Question: Generate an informative caption for the figure above.
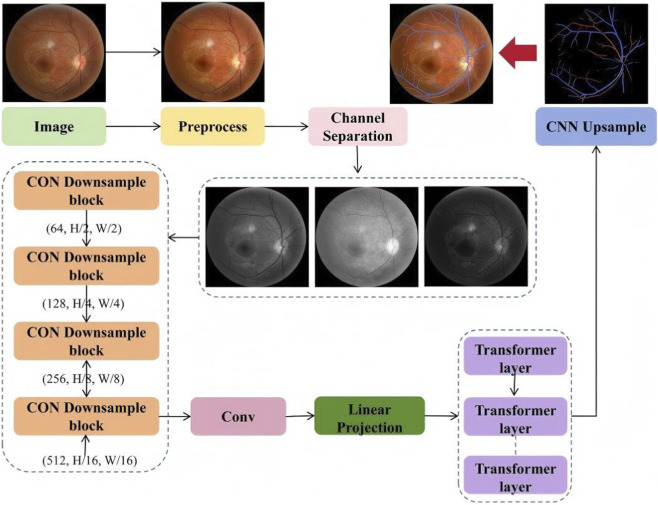
Answer: Flowchart of artificial intelligence-assisted retinal image processing and quantitative analysis.